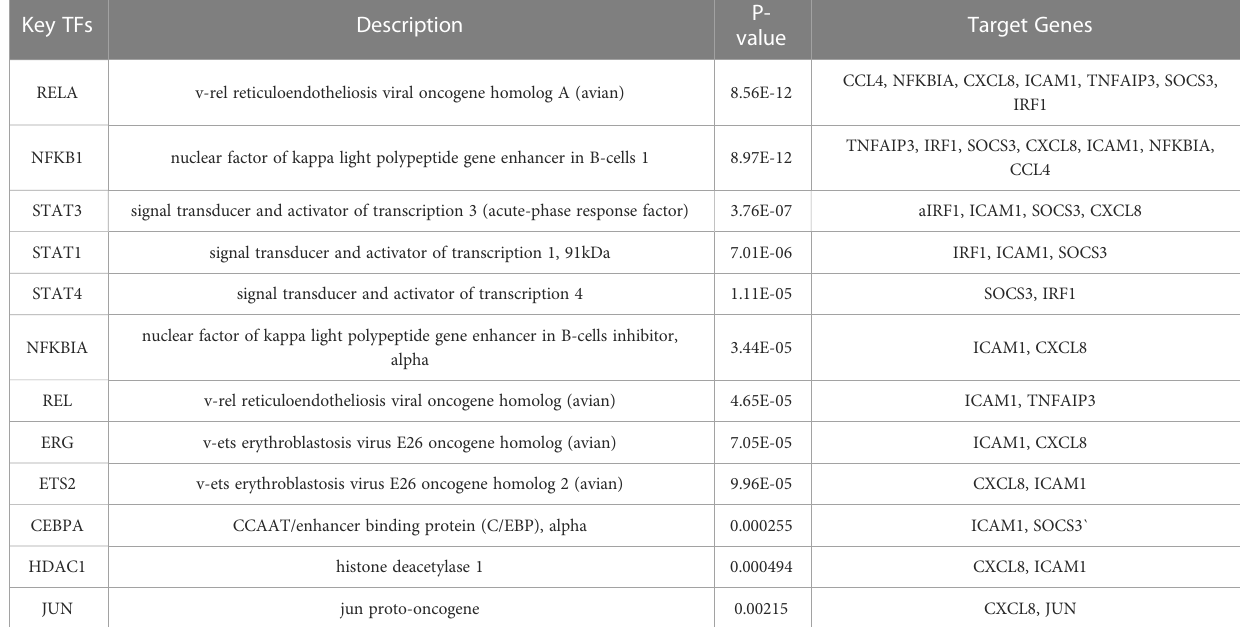
TABLE 3 Key transcriptional factors (TFs) of hub